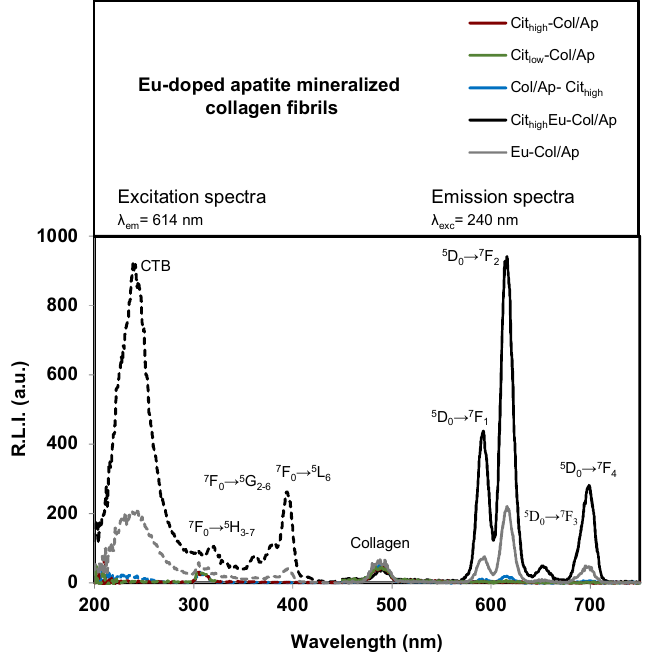
Figure 4. Uncorrected excitation (dashed lines) and emission (solid lines) spectra of different Eu 3+ – doped apatite mineralized collagen fibrils. Slit – widthsexc/em = 10/10 nm, td = 120 μs, tg = 5 ms and voltage detector = 600 v.